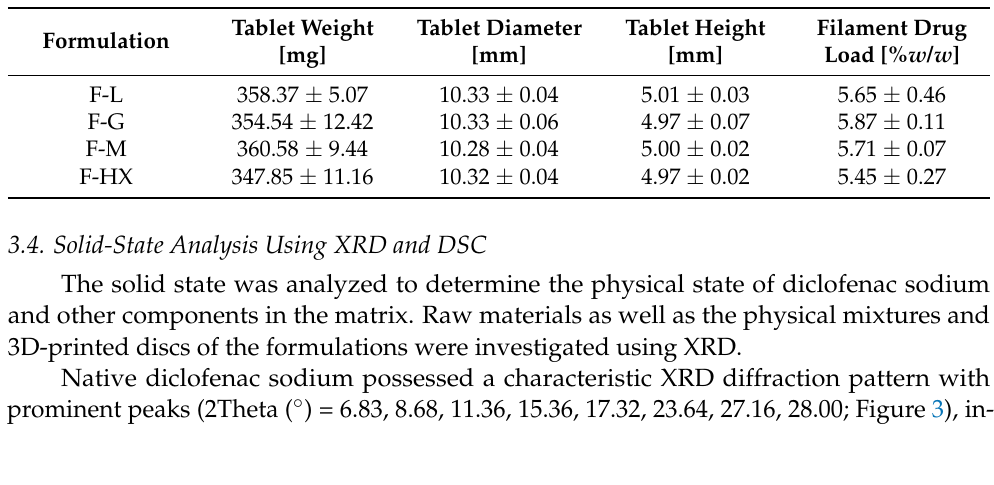
Table 5. Tablet characterization results of four 3D-printed formulations ( n = 10). Total filament drug load ( n = 3) calculated as a percentage of filament